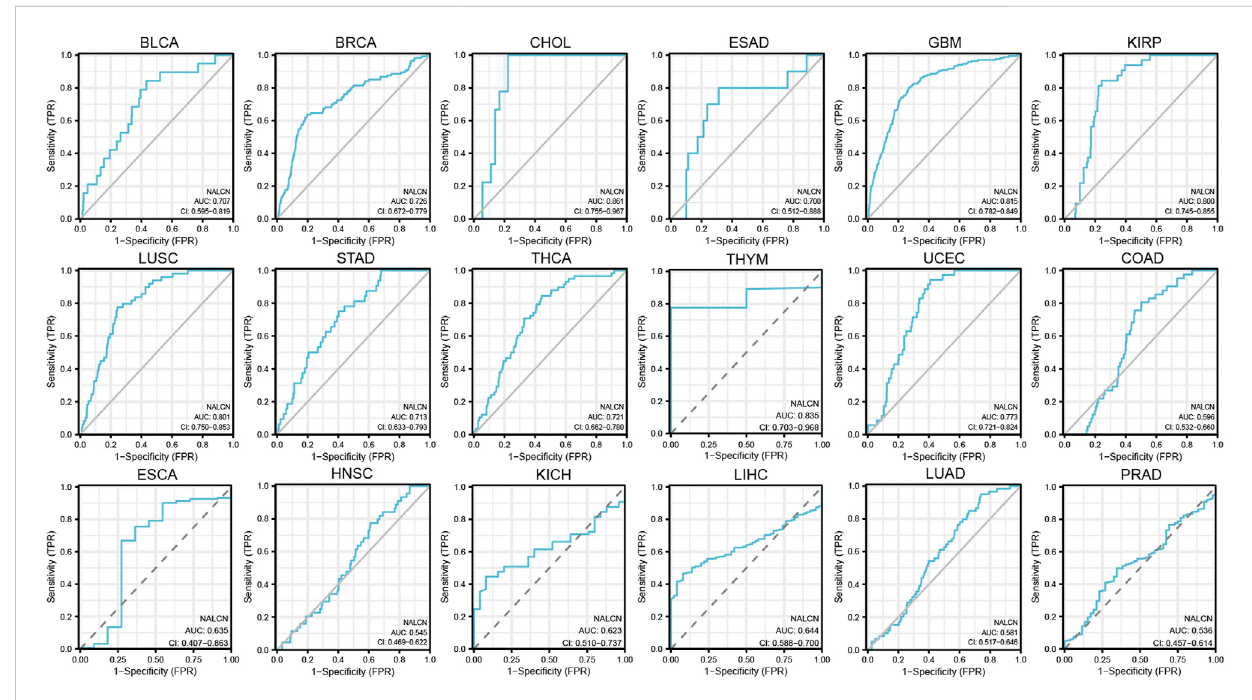
FIGURE 6 AUC of ROC curves showed the diagnosis performance of NALCN in the TCGA